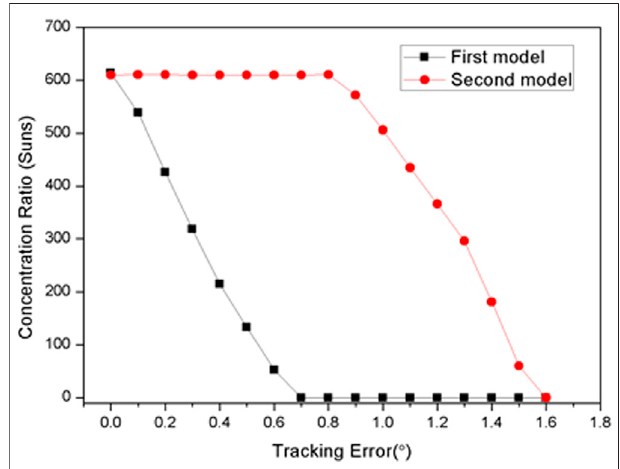
FIGURE 9 | Effect of the tracking error on the concentration ratio for the solar concentrators.